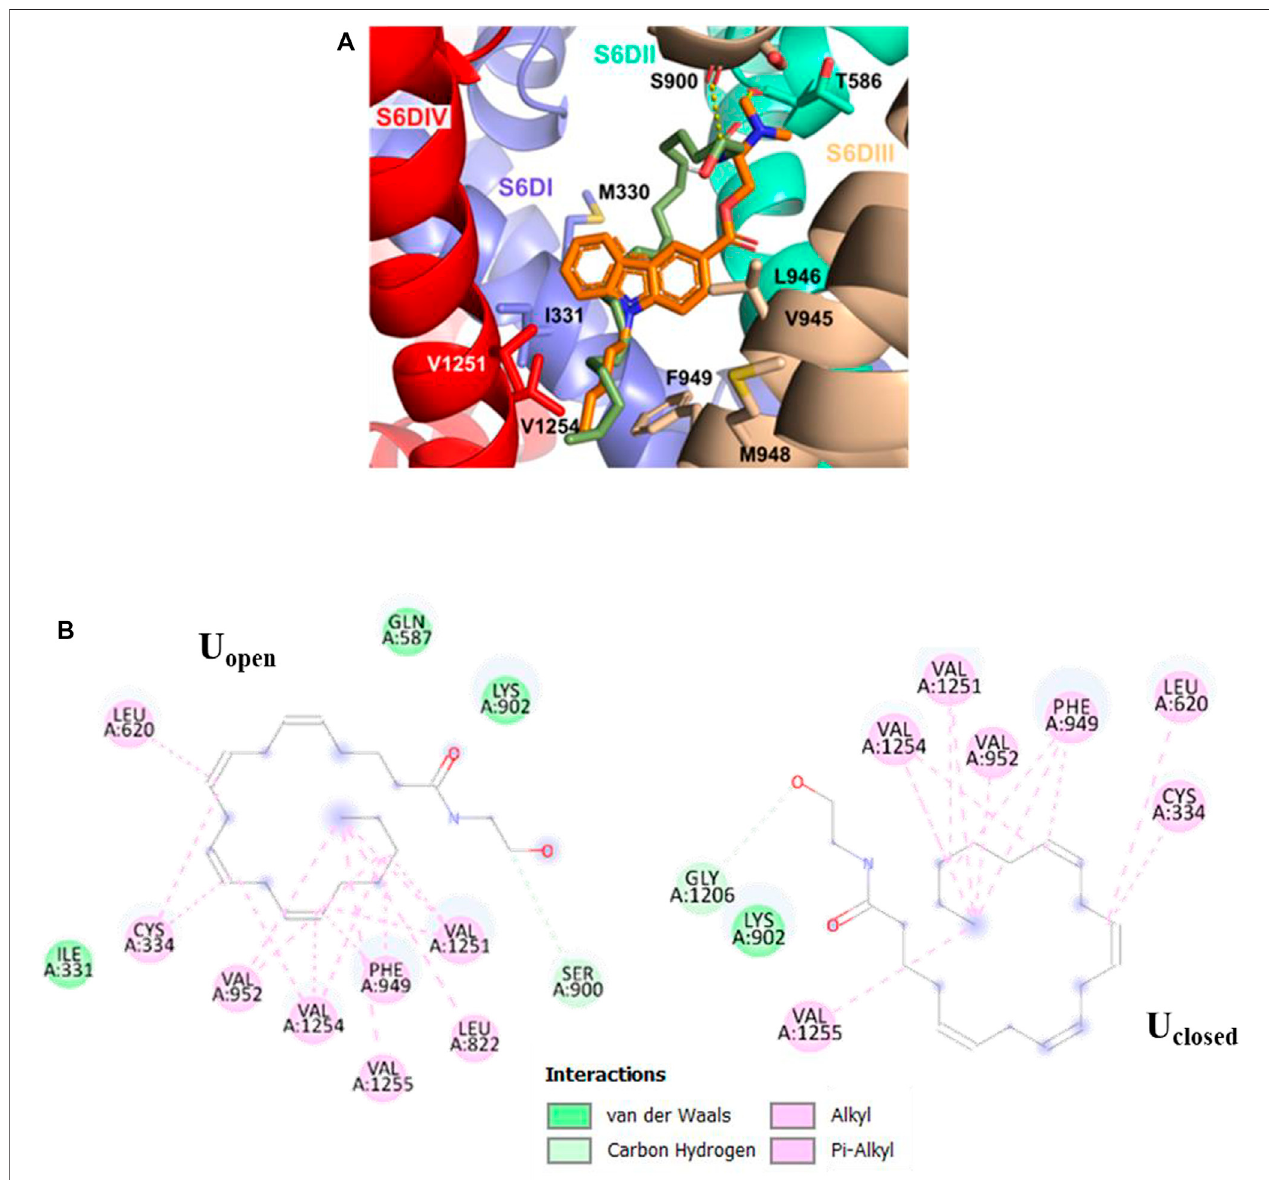
FIGURE5| MolecularinteractionsofU closed ,U open (green),andNMP-181(orange)withCa v 3.2. (A) 3DperspectiveofU open andNMP-181 atthepore-blockingsite in the Ca v 3.2 channel; (B) 2D perspective interaction for U closed and U open anandamide conformer in the pore-blocking site.